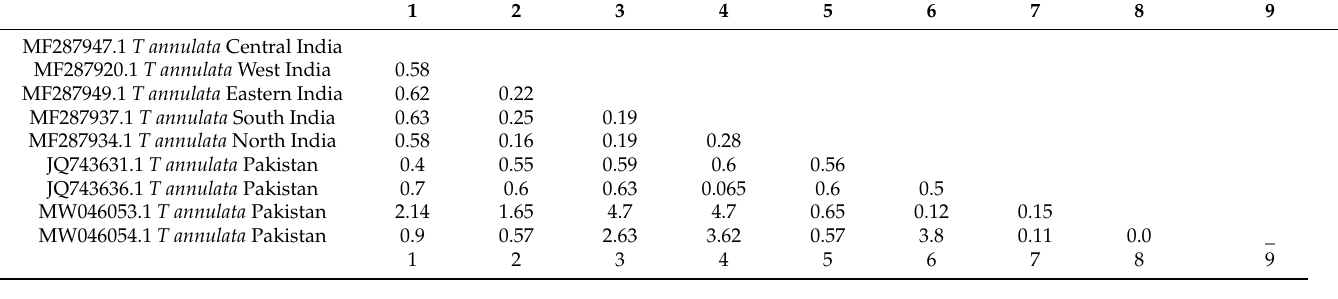
Table 9. Evolutionary divergence analysis of T. annulata 18S rRNA gene isolates.